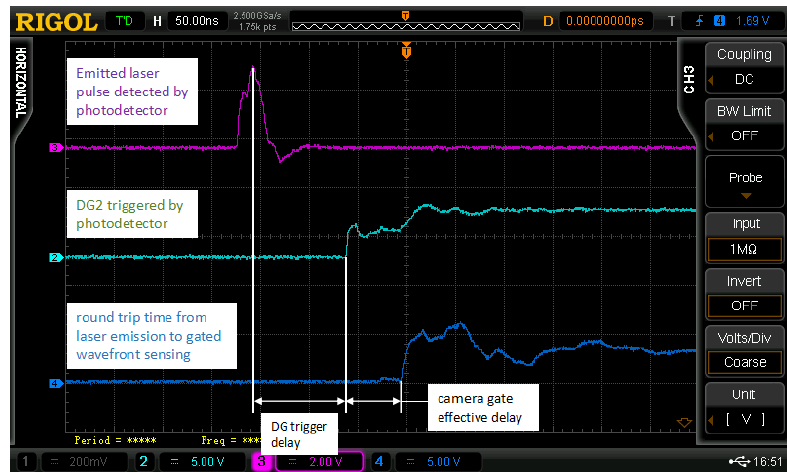
Figure 7. Determination of the actual delay generator (DG) trigger and camera delay time. The output from the photodetector shows in purple color; the output from the delay generator (DG) 2 shows in green color; and the camera gate output shows in blue color.